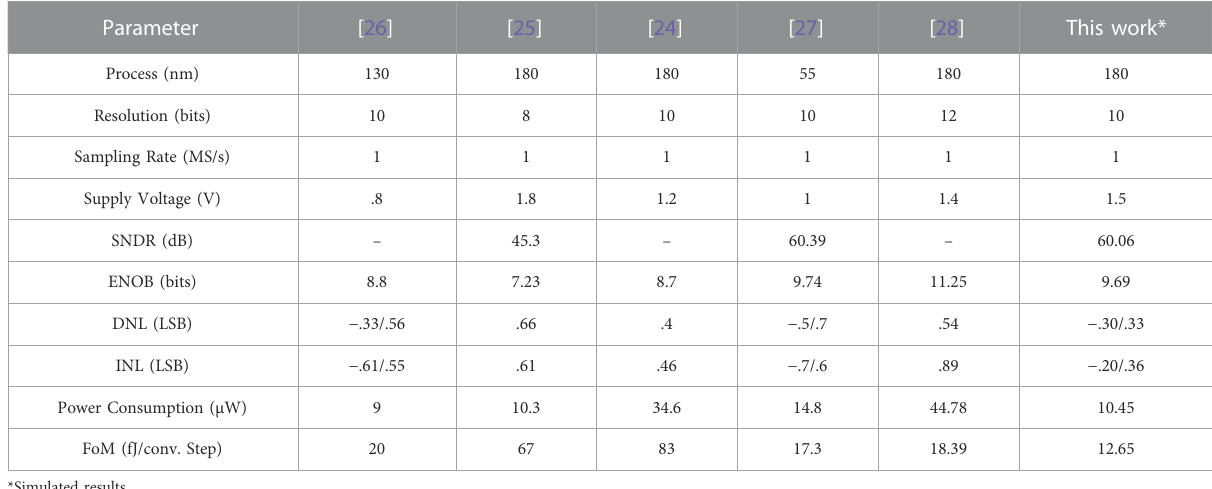
TABLE 2 Performance